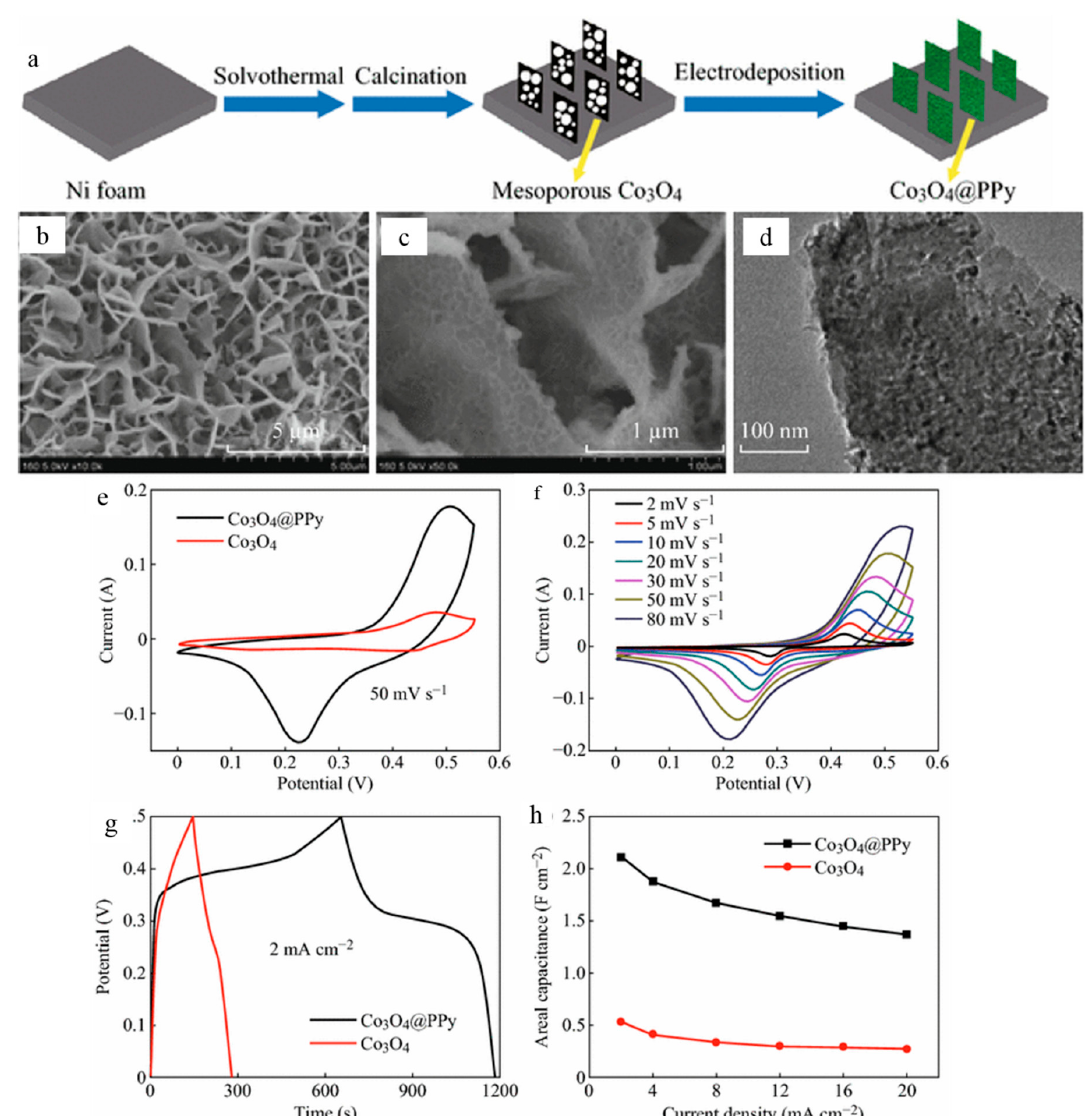
Figure 18. ( a ) Schematic diagram for the synthesis of mesoporous Co 3 O 4 @PPy hybrid nanosheet arrays on Ni foam, (b–d) SEM and TEM images of the Co 3 O 4 @PPy hybrid composites after 5 min electrodeposition, (e) CV curves of the Co 3 O 4 @PPy hybrid electrode and Co 3 O 4 electrode at a scan rate of 50 mV·s − 1 , (f) CV curves of the Co 3 O 4 @PPy hybrid electrode and Co 3 O 4 electrode at various scan rates, (g) CD curves of the Co 3 O 4 @PPy hybrid electrode and Co 3 O 4 electrode with a current density of 2 mA·cm − 2 and (h) Areal capacitances of the Co 3 O 4 @PPy hybrid electrode and Co 3 O 4 electrode at various current densities [147] .